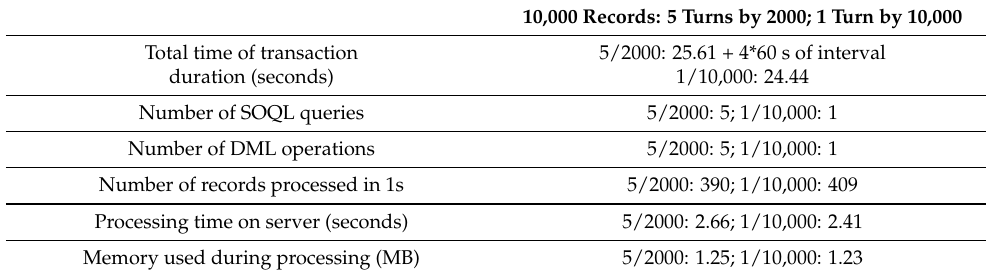
Table 12. Apex Schedulable processing results for update operation.